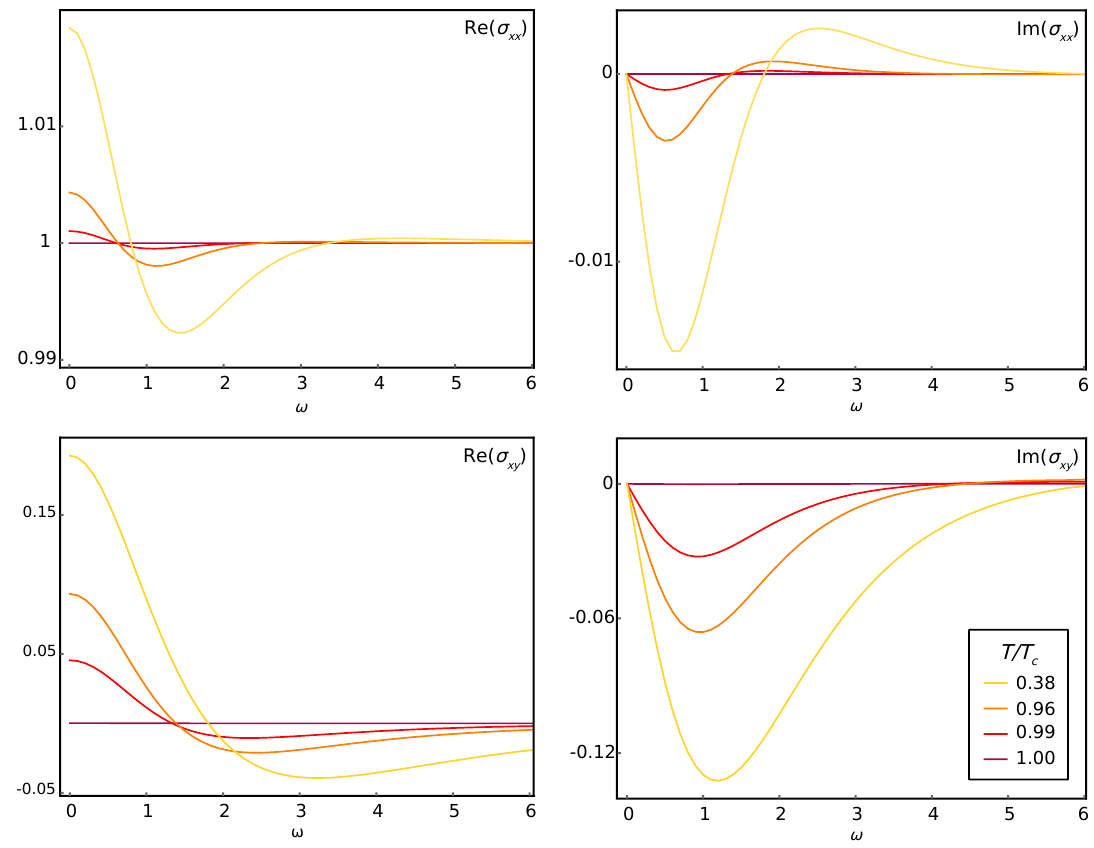
Figure 7 . Top panels: real (left) and imaginary (right) parts of the conductivity σ xx as a function of the frequency for various values of T/T c . Bottom panels: real (left) and imaginary (right) parts of the Hall conductivity σ xy as a function of the frequency for various values of T/T c